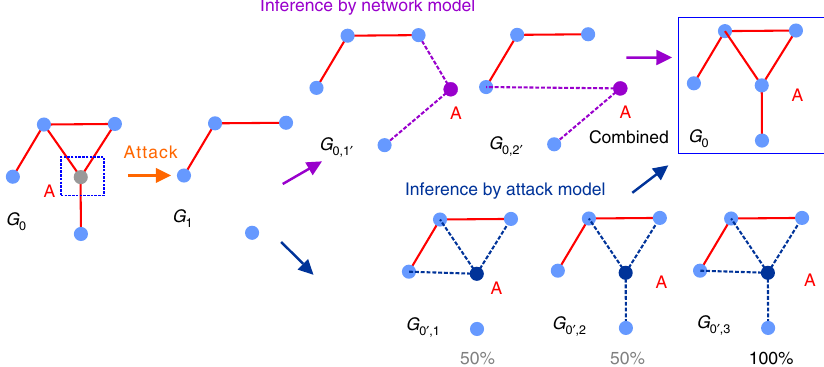
Fig. 1 A motivating example. An illustrative example to show the importance of combined consideration of network model and interventional